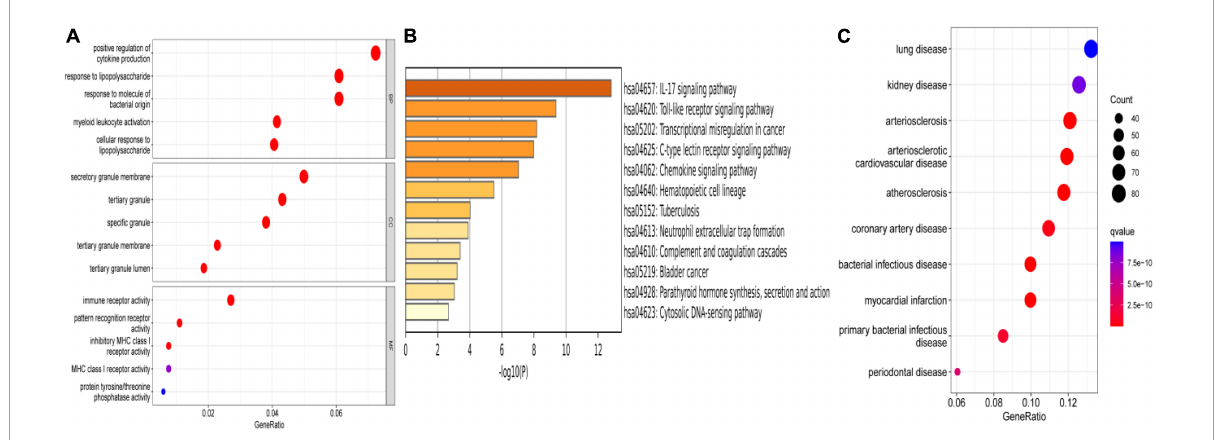
FIGURE3 Enrichment analysis. (A) GO enrichment analysis of DEGs. (B) KEGG enrichment analysis of DEGs. (C) DO enrichment analysis of